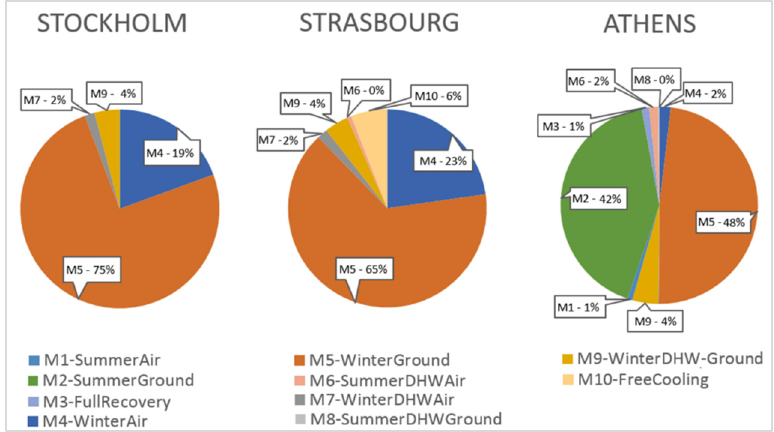
Figure 11. Percentage of energy production in each operating mode (year 15).